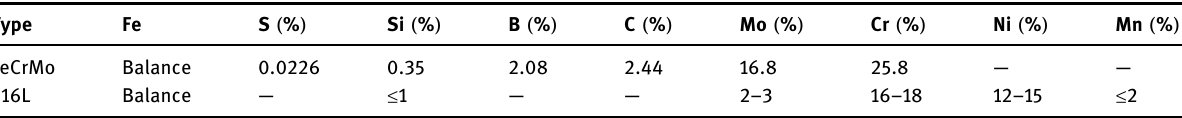
Table 1: Contents of FeCrMo powder and 316L stainless steel ( wt% ) Type FeCrMo